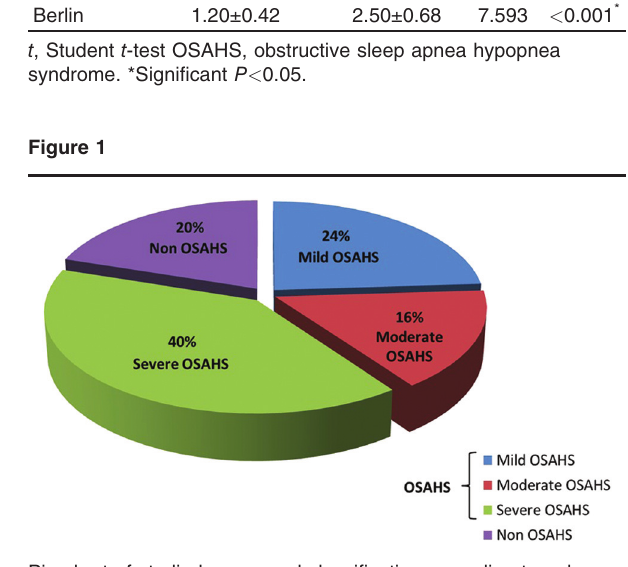
Pie chart of studied cases and classification according to polysom- nography. OSAHS, obstructive sleep apnea hypopnea